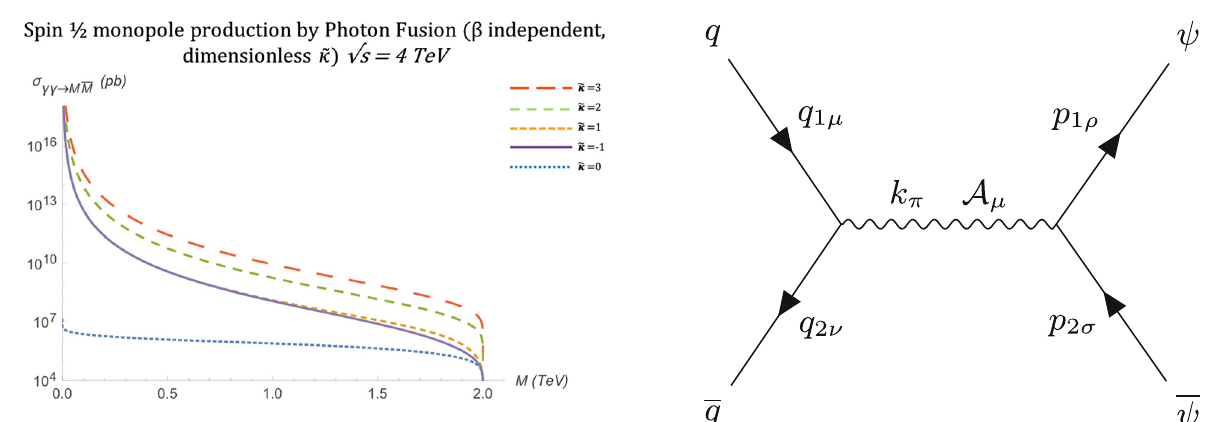
Fig. 10 Total cross section for the pair production of spin- 1 / 2 monopoles via the PF process, as a function of the monopole mass √ M for different values of ˜ κ at s γγ = 4 TeV